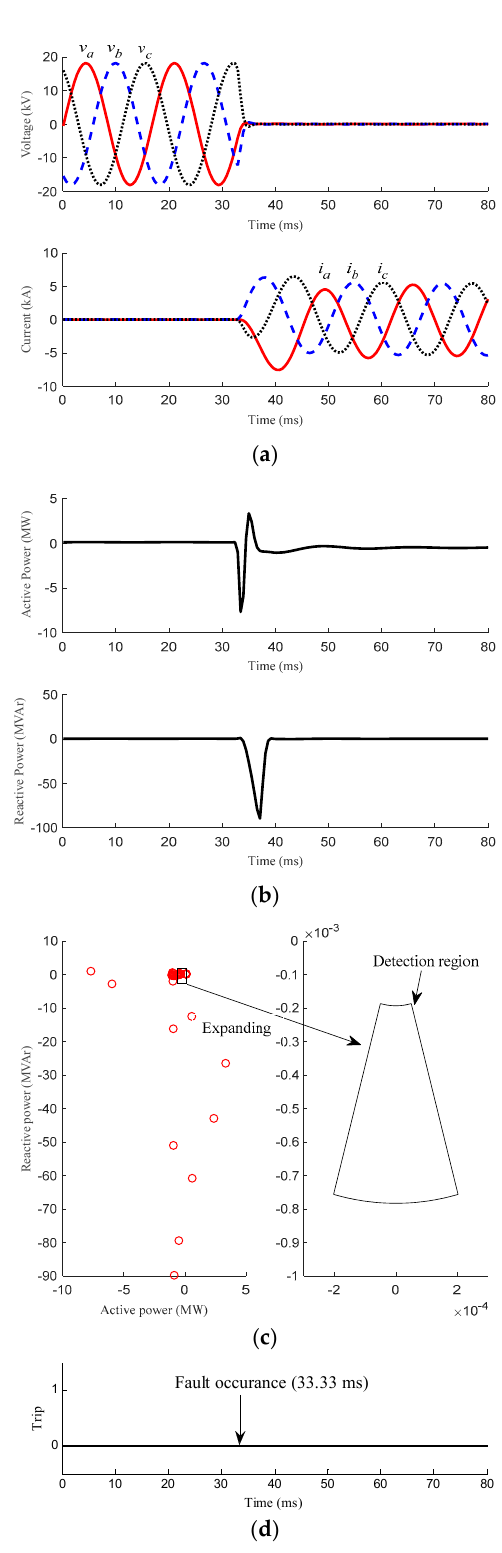
Figure 7. Results for Case 5. ( a ) v a , b , c (upper) and i a , b , c (lower); ( b ) p 3 ph (upper) and q 3 ph (lower); ( c ) Trajectories of the point ( p 3 ph , q 3 ph ); ( d ) Islanding detection signal. The results indicate that the proposed method does not activate the islanding detection signal no matter where a fault